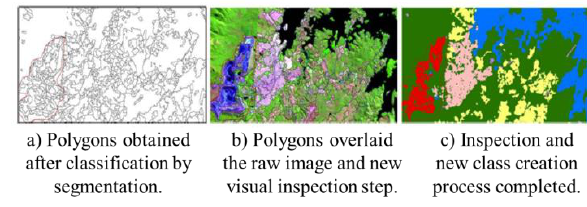
Figure 3. Visual inspection process performed after the segmentation classification process exemplified by a mining company.